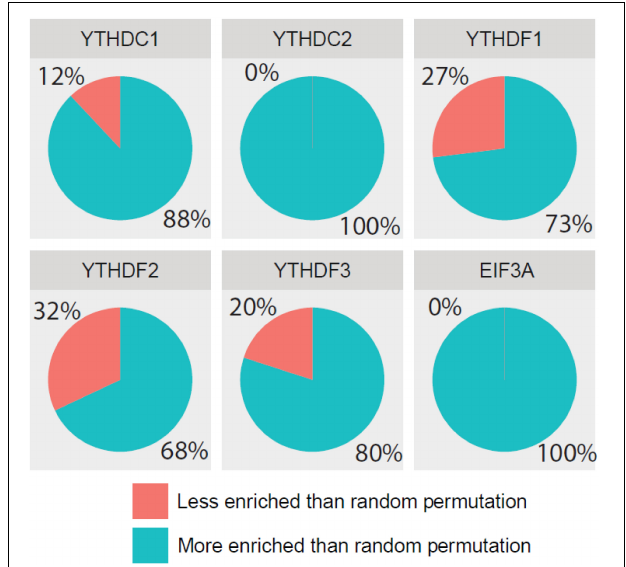
FIGURE 6 | Comparing detection of m 6 A readers’ targets based on biological significance. The most significant p -values of top 10 GO terms treated with negative logarithm were added up, and those results of identified targets were compared with those of randomly selected substrates. With the bootstrap sampling approach, substrates were randomly selected and analyzed for 100 times before the results were summarized as proportions and displayed in pie